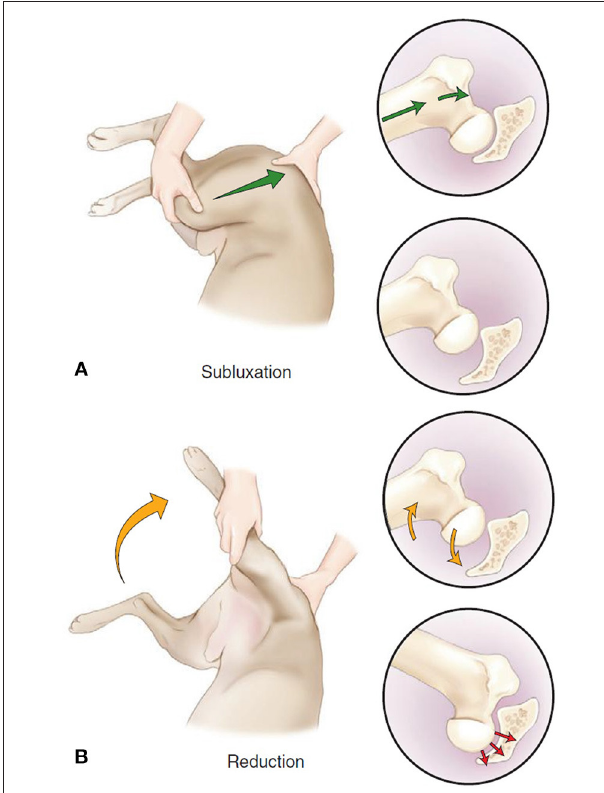
FIGURE 2 | The Barlow and Ortolani test in dogs. (A) “Barlow” (subluxation) test. The dog is positioned in lateral or dorsal recumbency. In lateral recumbency, the examiner is caudal to the dog with one hand on the distal stifle (flexed to 90 degrees) and the other is dorsal to the pelvis, with the thumb resting over the greater trochanter. The limb is in an adducted position, and force is applied toward the dorsum of the dog up through the femur (green arrow), causing dorsal subluxation in a hip with joint laxity. (B) Ortolani (reduction) test. The limb is slowly abducted (yellow arrow) while force along the axis of the femur is maintained. A positive Ortolani sign is felt when a click or clunk is heard or palpated as the subluxated femoral head reduces into the acetabulum (red arrow). Figure reproduced without modification from (56) under the Creative Commons Attribution 4.0 International License ().